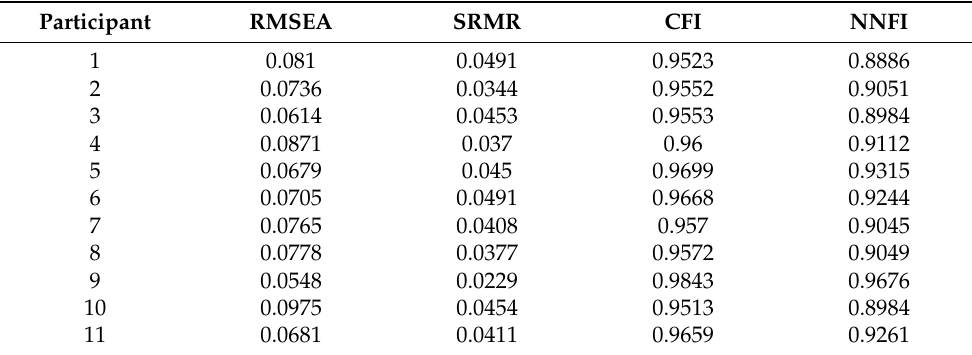
Figure 4. Group-level effective connectivity map recovered by HRF-GIMME. Solid lines represent contemporaneous connections; dotted lines represent lagged connections, curved black arrows represent autoregressive effects. Note that variables specific and general indicates the direct effects of the task on the other ROIs. In other words, the degree to which a task influences variability in BOLD activity at the corresponding ROI. n = number of participants in the sample that had a significant path at the group-level, R = right, L = left. Table 3. Fit statistics.